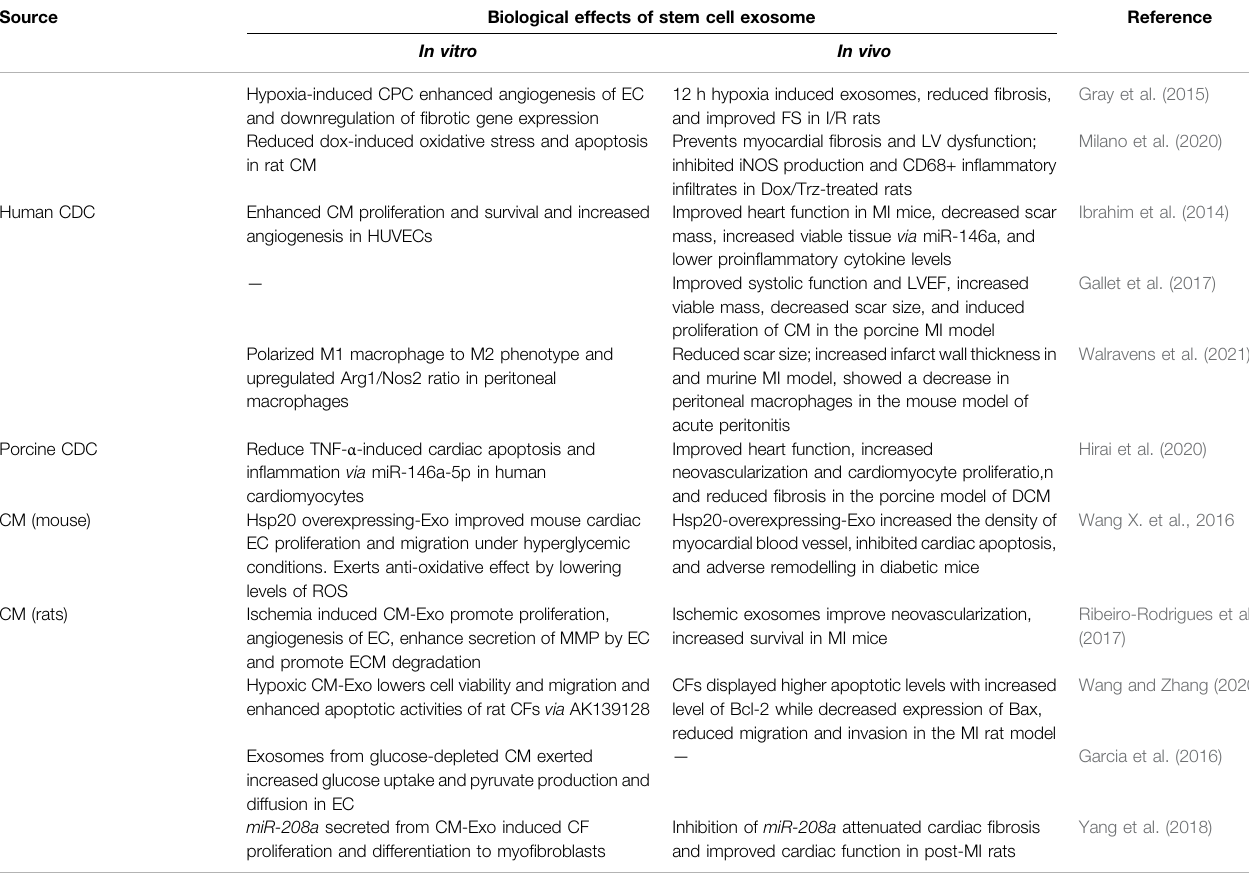
Table1| ( Continued )Cardioprotectivemechanismsofstemcellexosomes.Asummaryofvariousmechanismsinvolvingstemcellexosomesincardiacrepairidenti fi edusing in vitro and in vivo